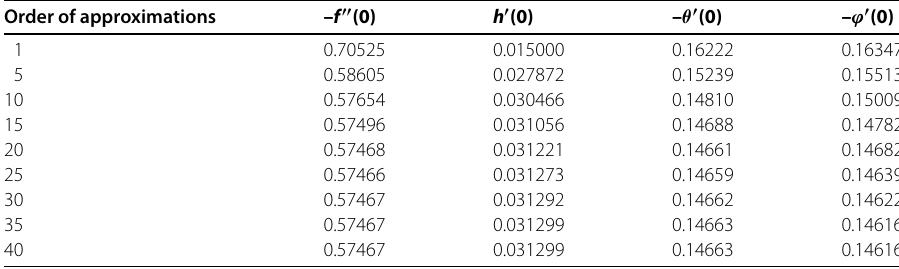
Table 1 Merging of series results for altered order of calculations when β = m =